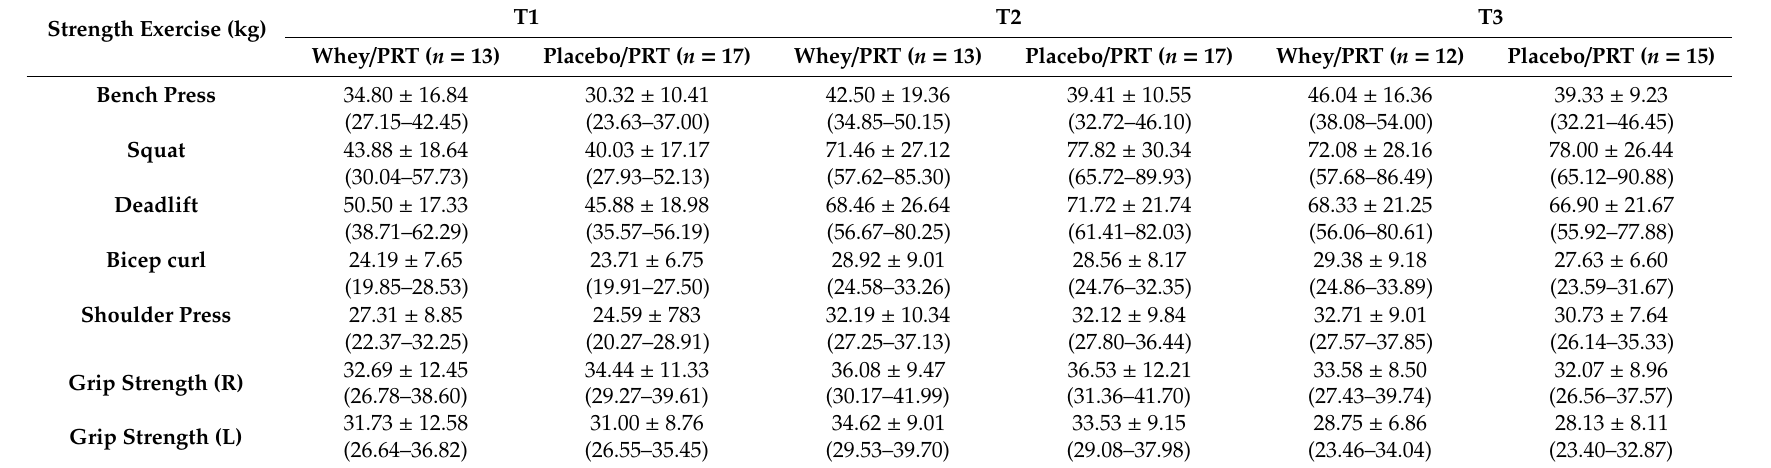
Table 2. Strength variables in the whey / PRT (progressive resistance training) and placebo / PRT